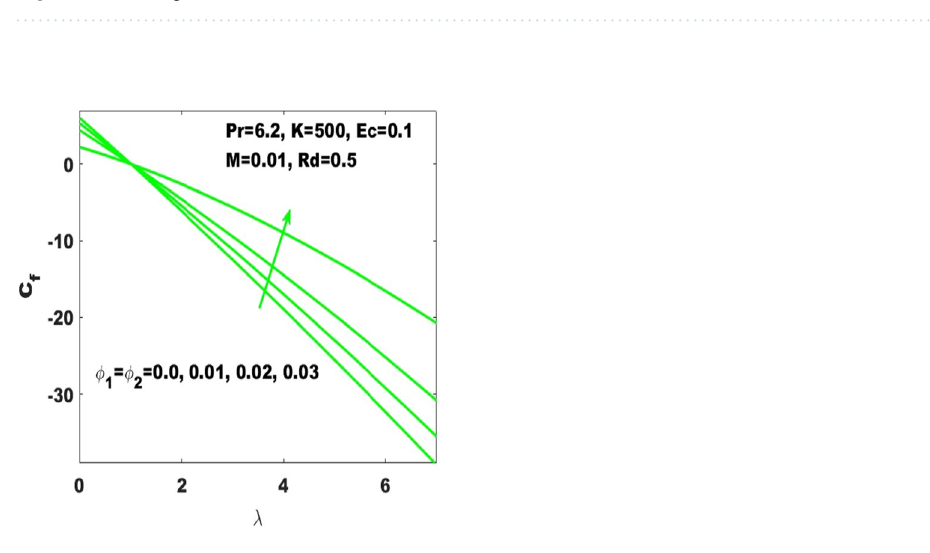
Figure 11. Change in C f with (cid:31) for diverse values of K .